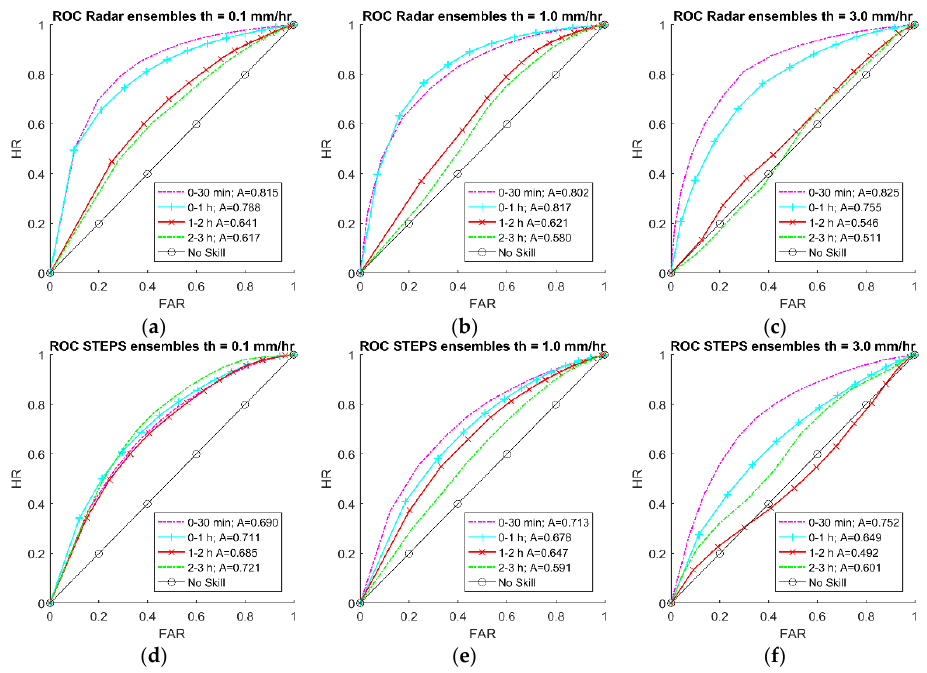
Figure 5. ROC curves for radar and STEPS ensembles for event on 1 August 2008 starting at 01:30 for Radar ensembles and rainfall thresholds (th) equal to 0.1 mm/h ( a ), 1.0 mm/h ( b ) and 3.0 mm/h ( c ). and STEPS ensembles and rainfall thresholds equal to 0.1 mm/h ( d ), 1.0 mm/h ( e ) and 3.0 mm/h ( f